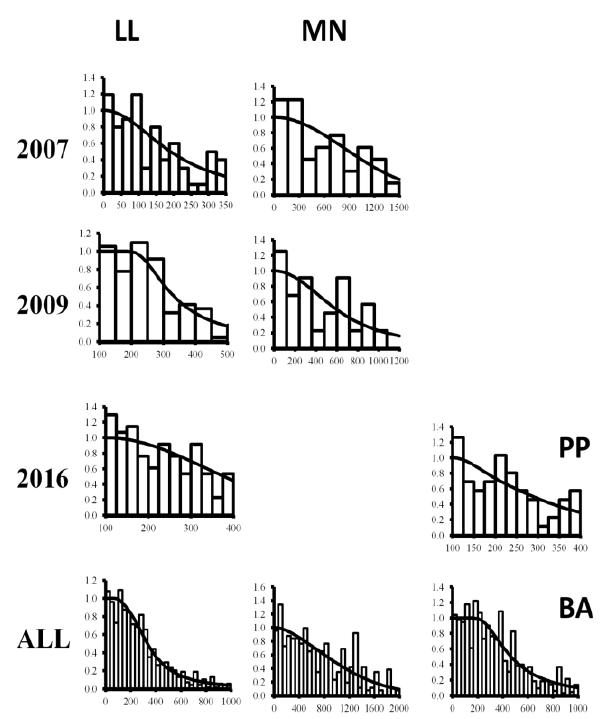
Figure 10. Detection functions (solid line) and sightings by species and survey, and for all surveys combined (ALL). X-axis – perpendicular distance (m); Y-axis – sighting probability. LL – white-beaked dolphin; MN – humpback whale; PP – harbour porpoise; BA – common minke whale. The best MRDS model for the right side duplicate data included only radial distance as a covariate and resulted in an estimated p (0) of 0.55 (CV=0.10) for the primary platform. The fully corrected total estimate was 9,588 (95% CI: 5,274 –